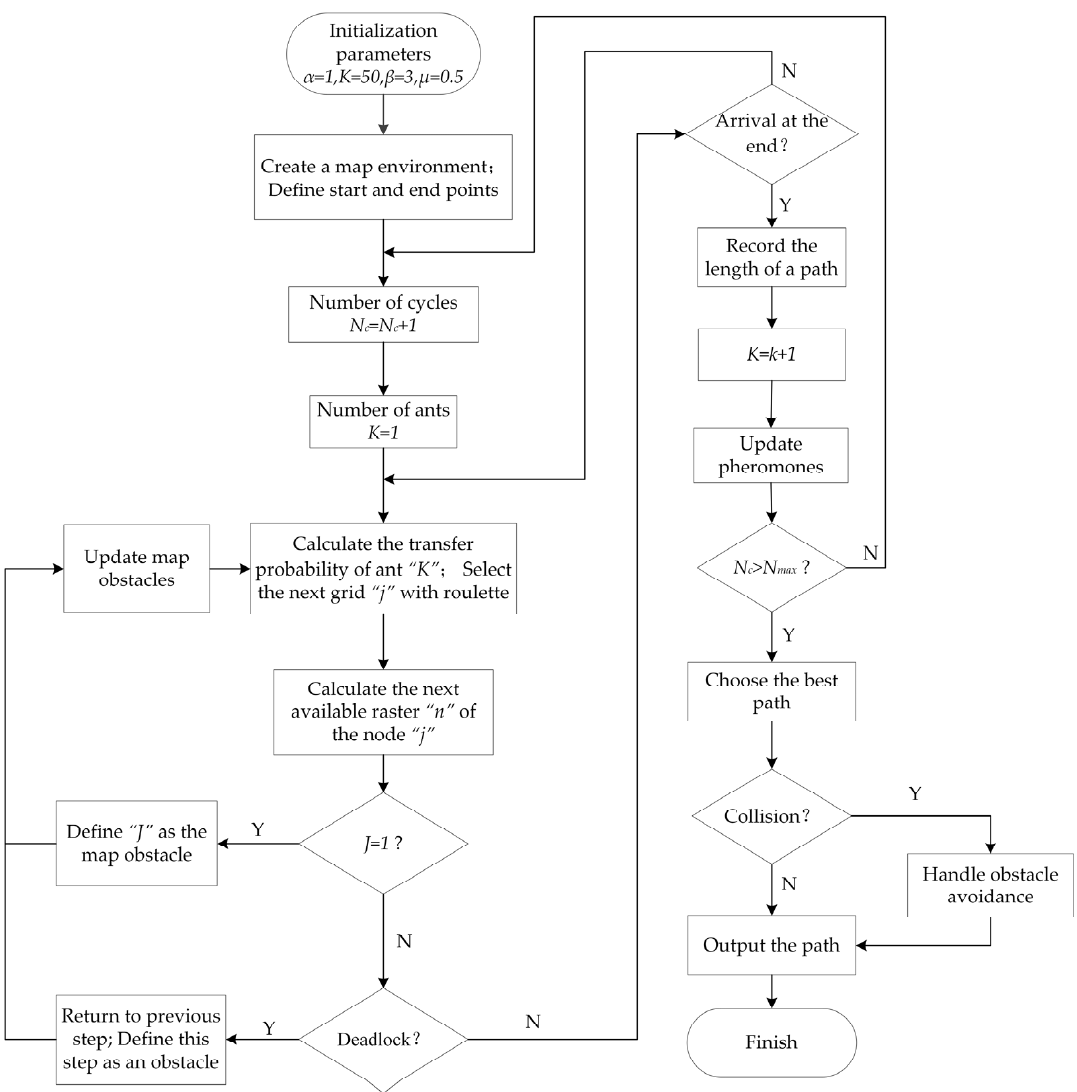
Figure 10. Flow chart of the optimization algorithm